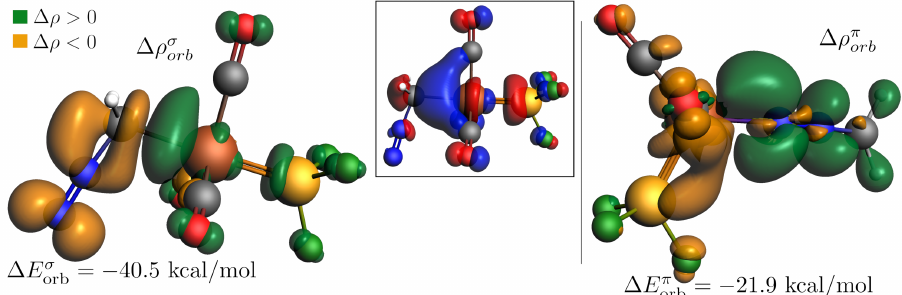
Figure 4. Natural orbitals of chemical valence (NOCV) deformation densities associated with the dominant interaction of the diazomethane complexes 3F1 (left) and 3FN (right). The inlet shows the acceptor NOCV orbital of 3F1 with the eigenvalue of